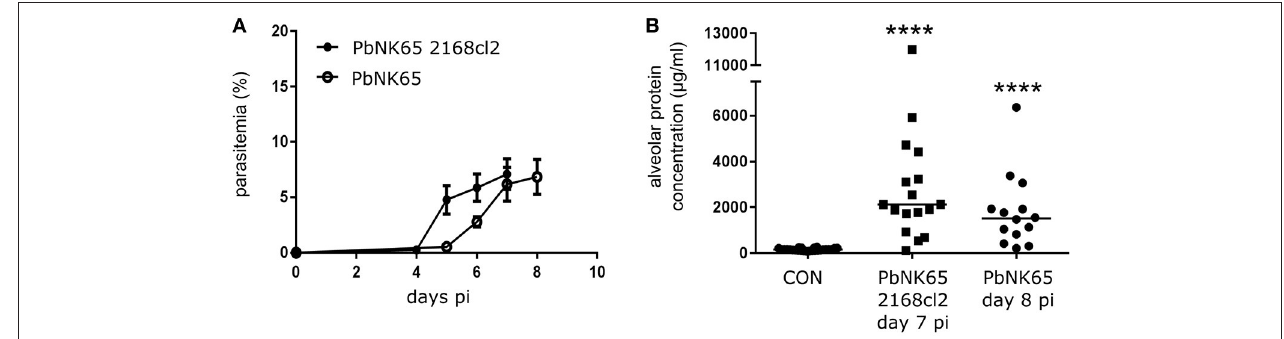
FIGURE 1 | PbNK65 2168cl2 and PbNK65-infected C57BL/6 mice develop MA-ARDS. C57BL/6 mice were infected with PbNK65 2168cl2 or PbNK65. (A) Peripheral parasitemia was determined at indicated days with Giemsa-stained smears of tail blood. Mean ± SEM are indicated. Compilation of two experiments, n = 10–20 per group. (B) Alveolar edema was measured by protein determination of BALF samples, collected at day 7 and day 8 pi from mice infected with PbNK65 2168cl2 or PbNK65, respectively. After centrifugation, the protein content of the supernatant was determined. Compilation of three experiments, n = 14–26 per group.